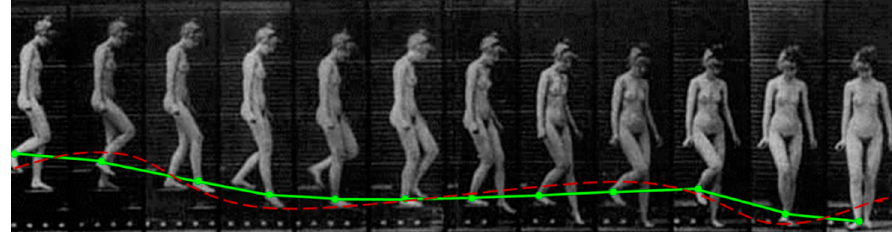
Figure 4. A fitting curve superimposed on a classic cinematographic picture of woman walking down stairs (Image courtesy of Motion Studies predating Taylorism, Images produced by Etienne-Jules Marey ).